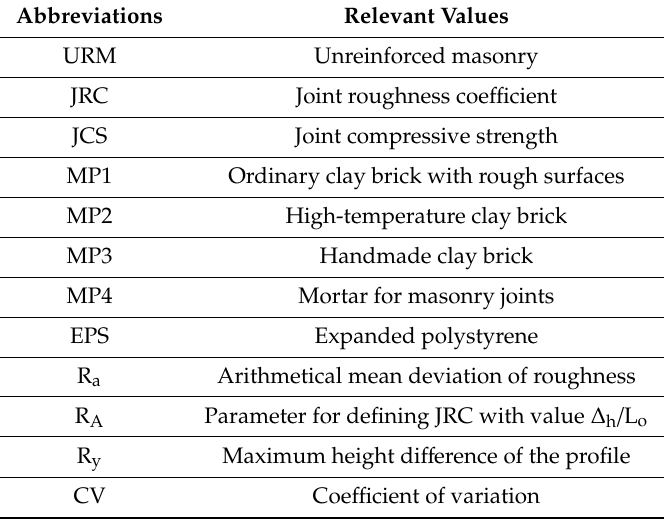
Table A1. With the abbreviations used in the text.